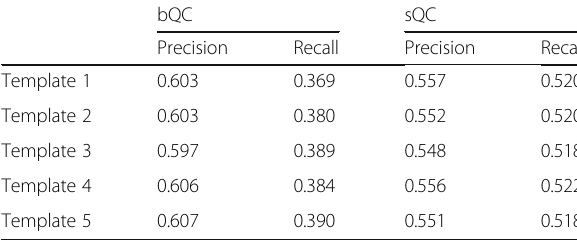
Table 14 QC model prediction results